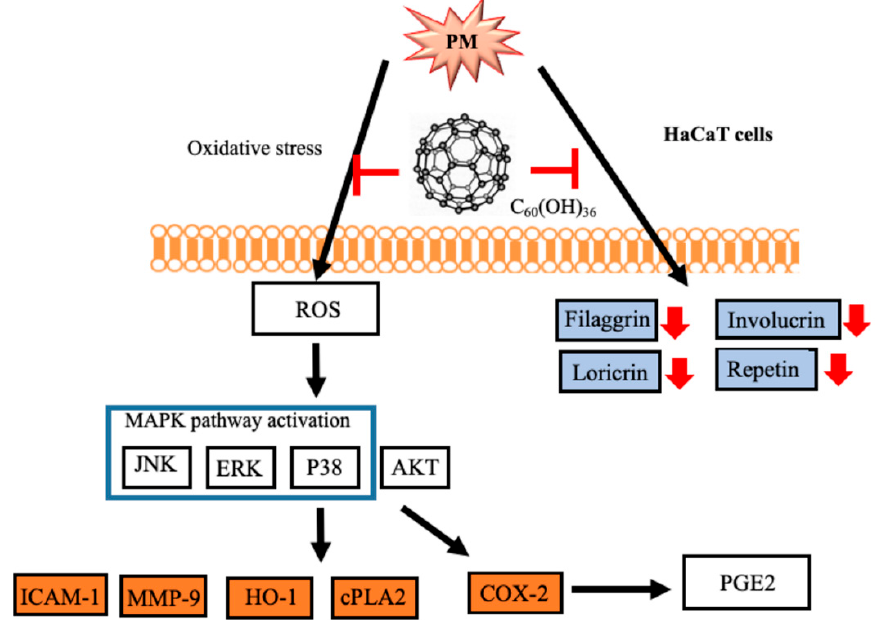
Figure 9. A diagram of the molecular mechanisms underlying the inhibition of PM-induced effects by fullerenols C 60 (OH) 36 in HaCaT cells. PM causes oxidation, inflammation, and barrier protein losses, which lead to cell toxicity. The levels of ROS were increased and triggered the activation of downstream MAPK and Akt pathways, and subsequently enhanced inflammatory protein (ICAM-1, COX-2, HO-1 and PGE2 etc.) expression. In addition, the loss of barrier proteins after PM exposure could be blocked by fullerenol C 60 (OH) 36 pre-treatment. This indicates that fullerenols C 60 (OH) 36 could act via ROS scavenger and anti-inflammatory mechanisms and the maintenance of expression of barrier proteins, to prevent PM-induced adverse effects in HaCaT cells.